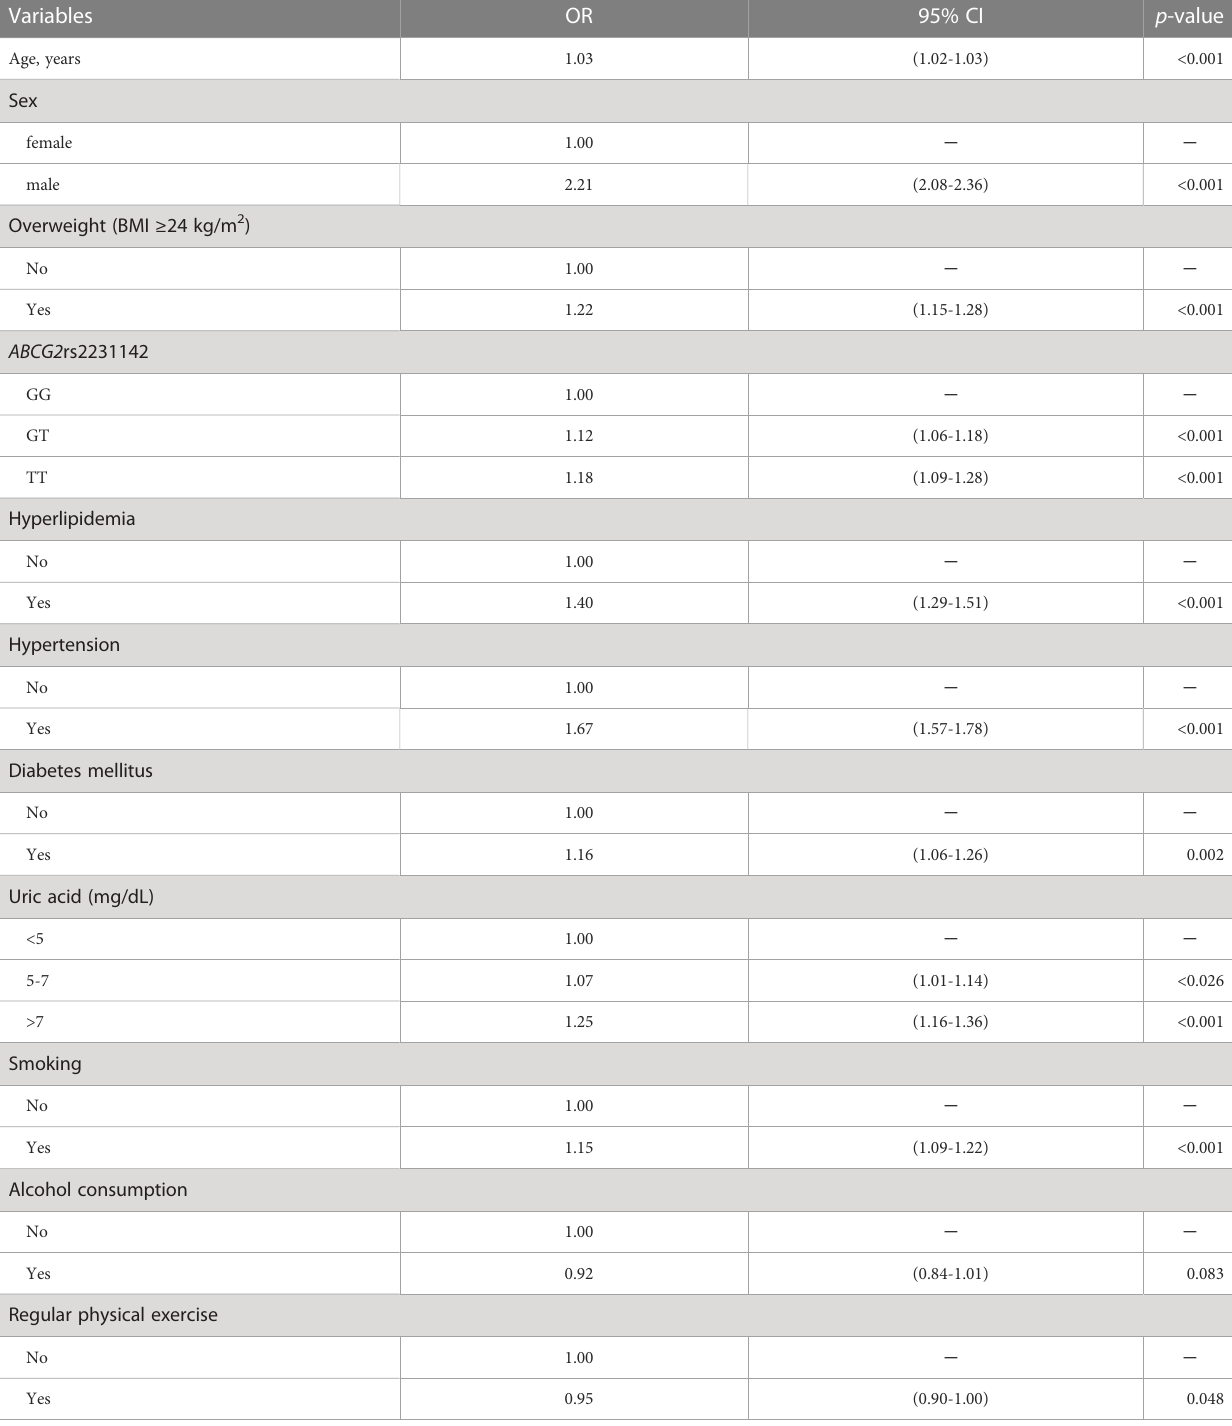
Results obtained from multivariable logistic regression analyses. Odds ratio (OR) adjusted for all variables in the table; BMI, body mass index; CI, con fi dence intervals. -, not